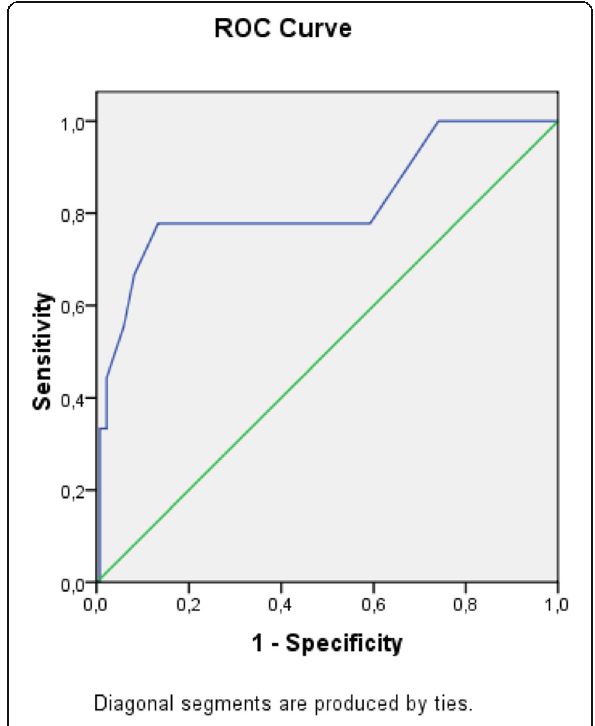
Fig. 1 ROC Curve for SOFA score